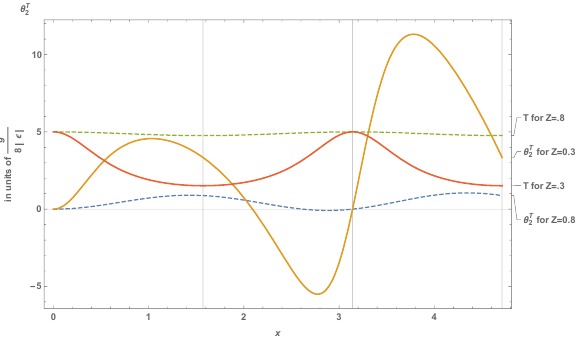
Figure 2: Faraday Rotation angle θ T 2 as a function of x = ωnL / c for Z=0.3 and Z=0.8. Transmission is multiplied by 5 to highlight the re- lationship between the Faraday ellipticity angle and corresponding transmission value, where T = 1 is the norm (colour